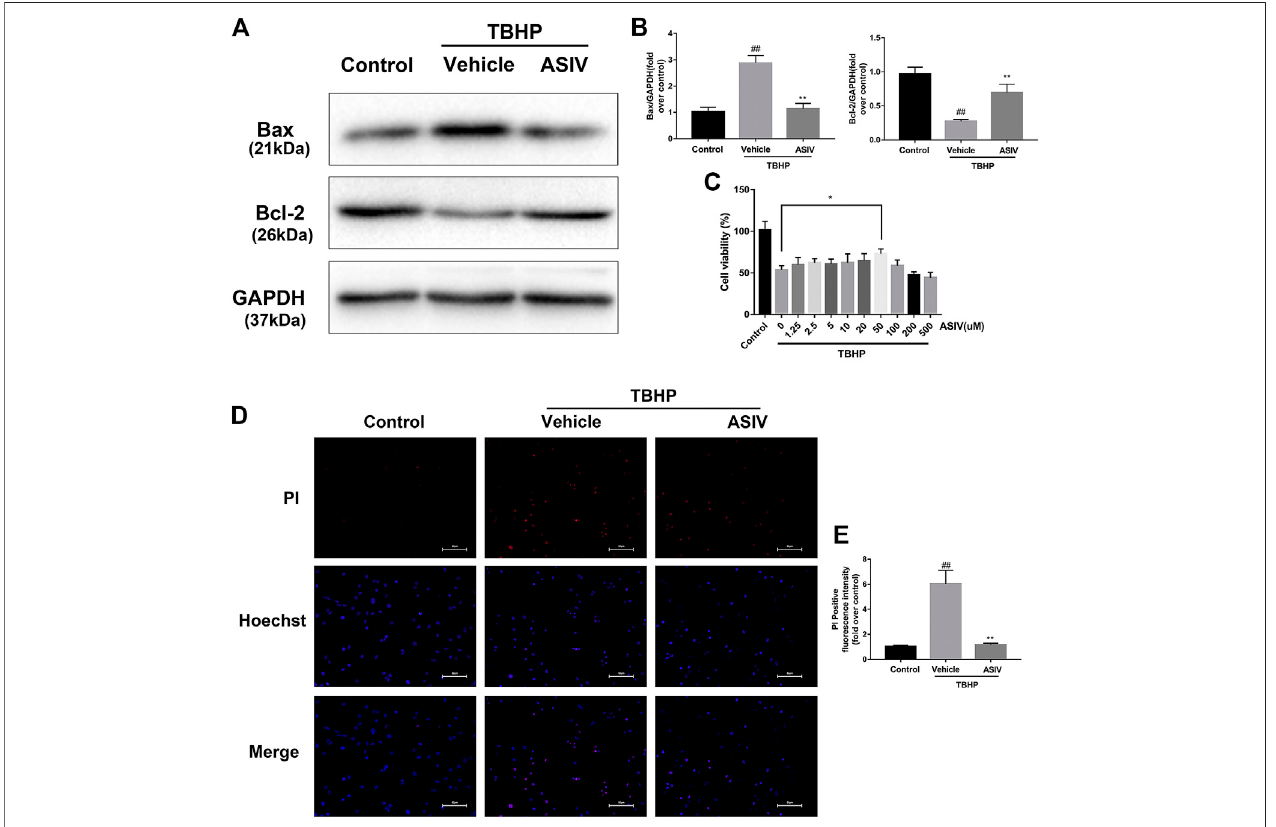
FIGURE 2 | ASIV attenuates TBHP-induced H9C2 cells injury. (A, B) After TBHP-induced injury, western blot results of Bax and Bcl-2 in the control group, TBHP group and ASIV treatment group were analyzed. (C) H9C2 cells were pretreated with ASIV(1.25, 2.5, 5, 10, 20, 50, 100, 200,or 500 μ M) for 12 h and then exposed to TBHP(250 μ M)for4 h,andcellviabilitywasmeasured. (D,E) PIstainwereanalyzedaftertreatedwithTBHPfor4 h.Scalebar:50 μ m n (cid:2) 6.Valuesareexpressedasthe means ± SD. # p < 0.05 compared with the control group, * p < 0.05 compared with the TBHP group (each test was repeated three